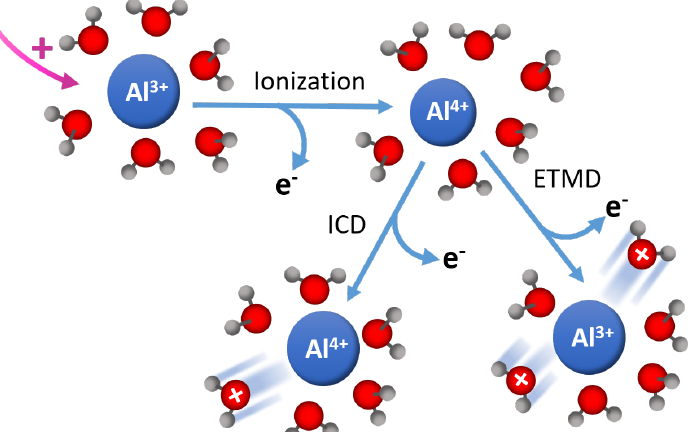
Figure 6. Ultrafast X-ray spectroscopies represent a new tool to understand the initial mechanisms that produce reactive species. Tunability throughout the soft-X-ray range allows access to important elemental species such as oxygen, nitrogen, and aluminum, of which, are of utmost importance for understanding these processes in high-level waste. For example, in complex solutions, alternative decay channels, such as ICD and ETMD, become operative. Shown here is the case for Al 3 + sur- rounded by H 2 O. In the case of concentrated solutions where ion-pairing may become prevalent, nearest neighbors may not be H 2 O, which could further serve to alter the production of reactive species through